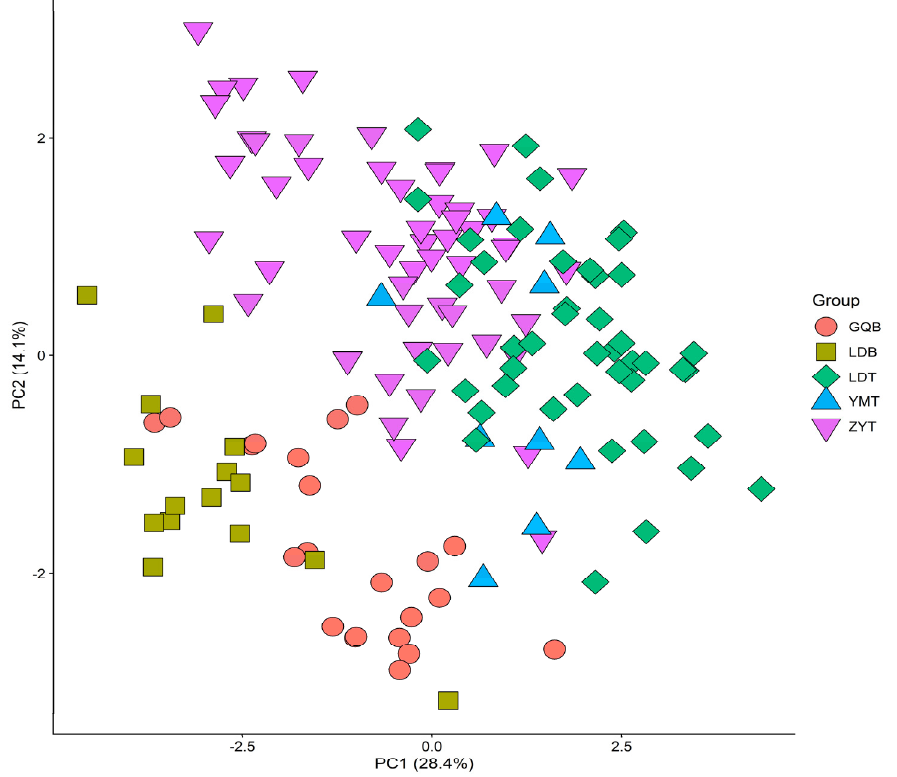
Figure 2. Principal component analysis of phenotypic characters measured of 145 samples of ancient tea plant germplasm.